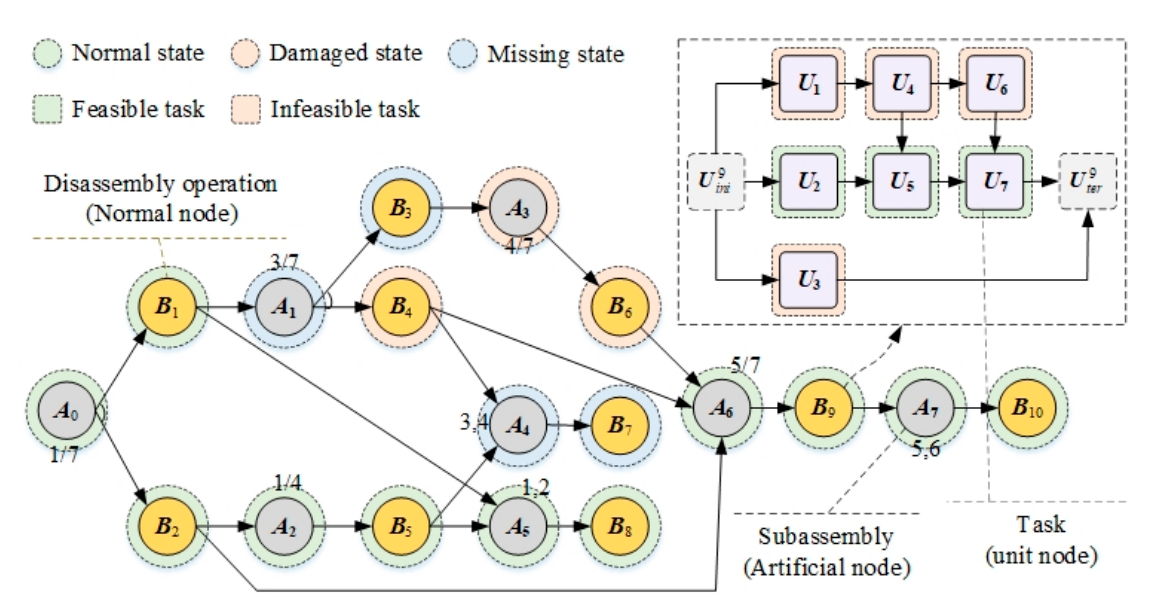
Figure 2. The TD-TAOG of the flashlight in the ℓ th environment.